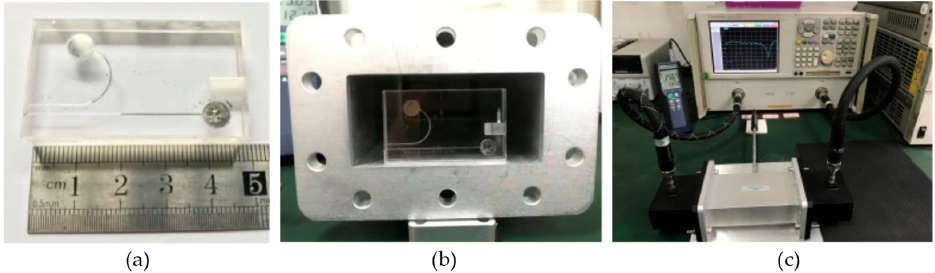
Figure 4. ( a ) Fabricated and assembled Hg-EIT-like metamaterial unit prototype, ( b ) the simple under test placed in the rectangular waveguide, and ( c ) the whole measurement setup.